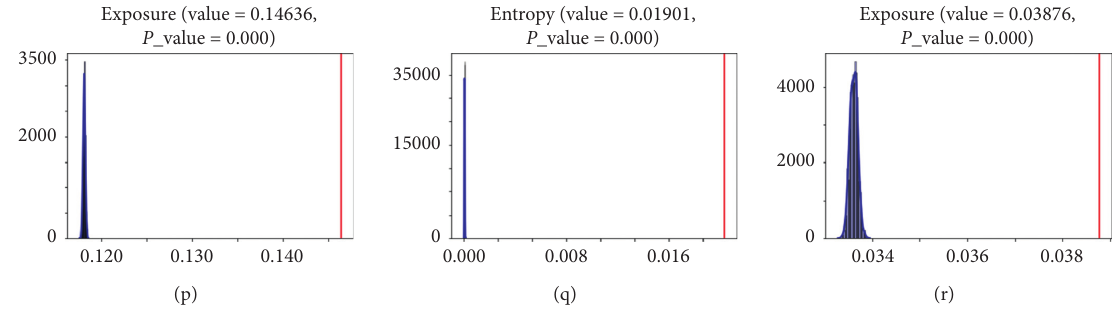
Figure 4: The statistical inference of information entropy in Hangzhou based on Census data. (a) Migrant H. (b) Migrant xPx. (c) Female H. (d) Female xPx. (e) Hukou H. (f) Hukou xPx. (g) Agriculture and husbandry H. (h) Agriculture and husbandry xPx. (i) Professional and technical H. (j) Professional and technical xPx. (k) Business and services H. (l) Business and services xPx. (m) Highly educated H. (n) Highly educated xPx. (o) Elderly H. (p) Elderly xPx. (q) Unemployment H. (r) Unemployment